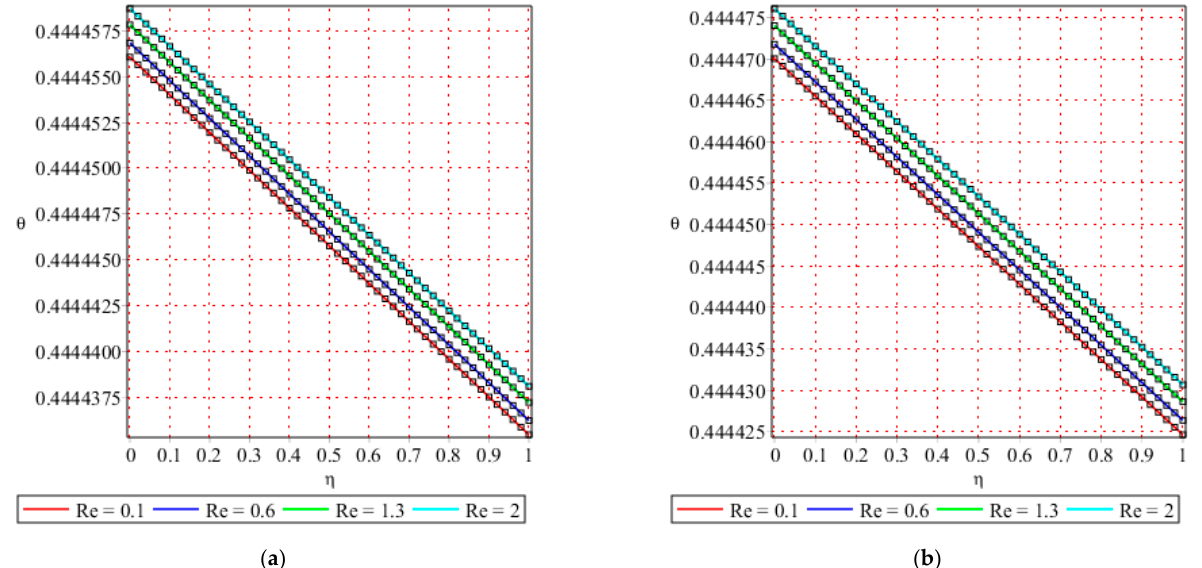
Figure 3. Influence of Re on ( a , b ). Temperature θ ( η ) . ( a ) SWCNTs , ( b ) MWCNTs